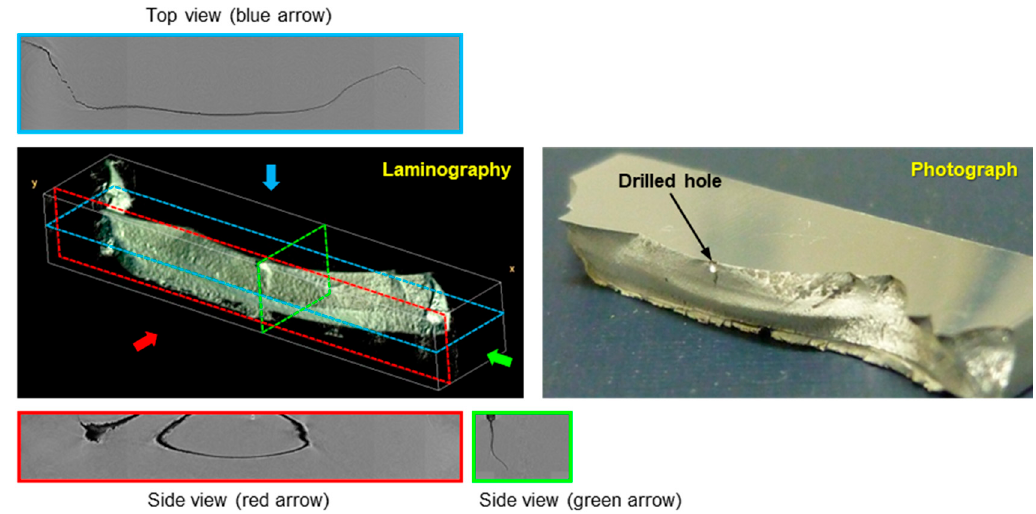
Figure 13. The reconstructed SR-based CL 3D image and a photograph of the fatigue crack.